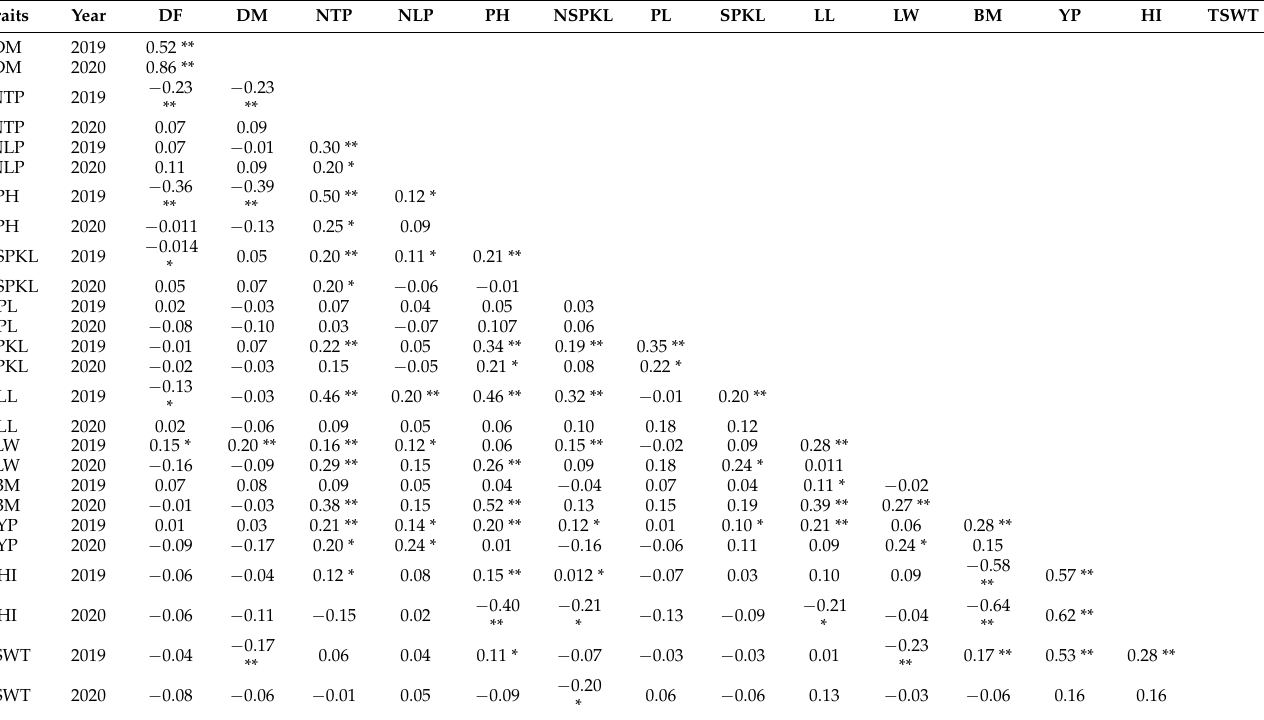
Table 2. Correlation analysis of 14 quantitative traits of 236 genotypes of Oat ( Avena sativa )